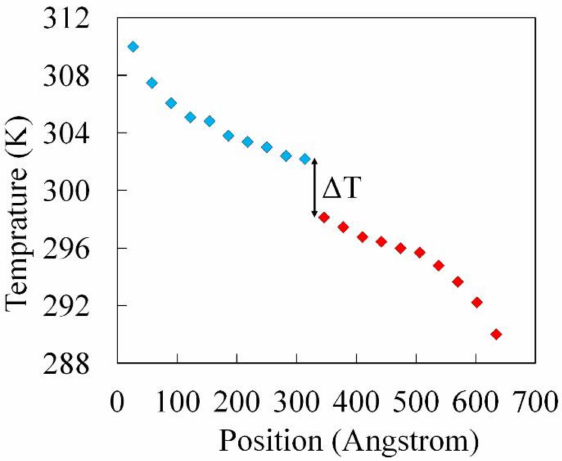
Figure 8. Temperature difference at the grain boundary for a single-layer sheet with length of 33 nm at 300 Kelvin. This temperature difference should be used in Equation (5) for the calculation of the thermal